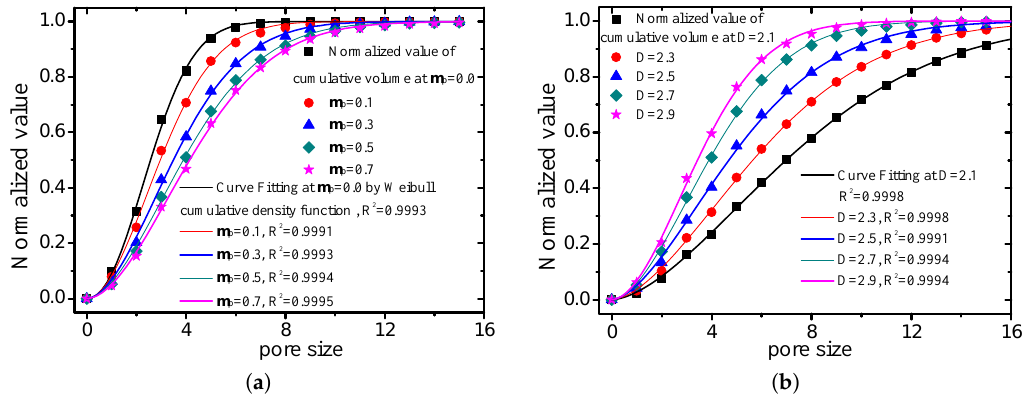
Figure 22. Curve fitting of normalized value of cumulative volume by Weibull cumulative density function (( a ) D is 2.5, while the friction coefficient takes different values; ( b ) µ p is 0.5, while the fractal dimension takes different